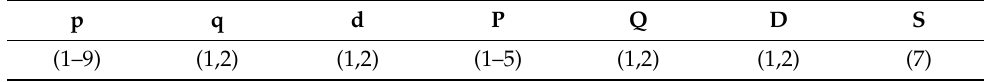
Table 1. Parameter range for the selection of the best SARIMAX model.